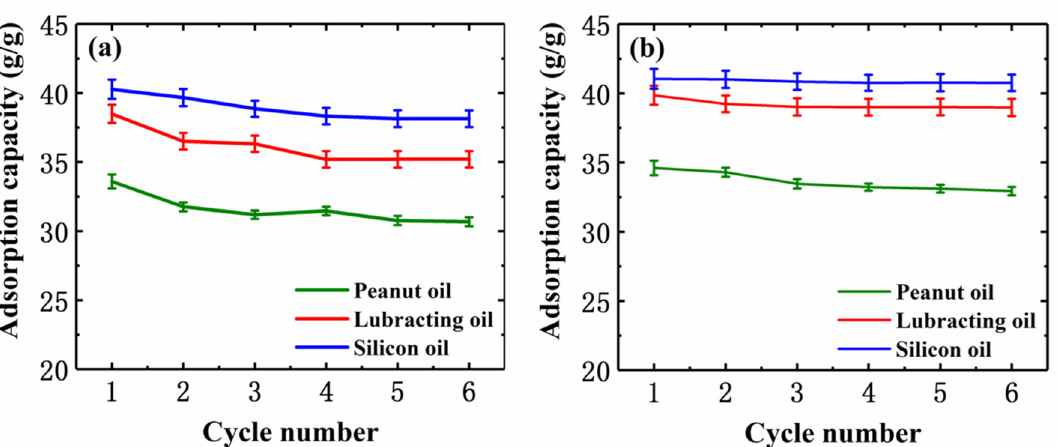
Figure 9. The adsorption capacities of composite sponge ( a ) sample 1 and ( b ) sample 2 for peanut oil, lubricating oil, and silicone oil over six cycles. Table 2. Oil adsorption capacity of different adsorbent materials.